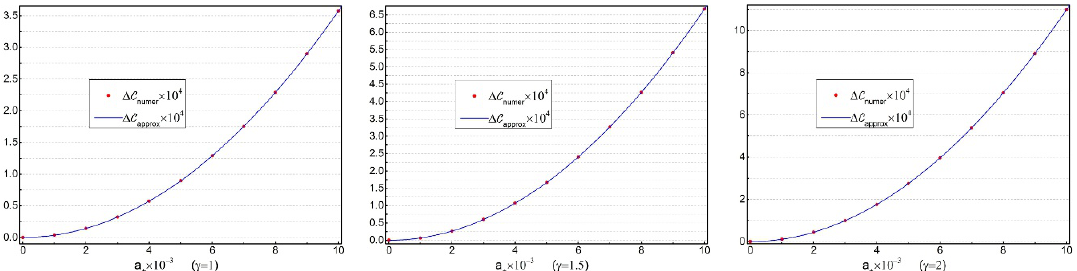
Figure 6 . Comparison between the quadratic approximation for small excitations, i.e., the second line of eq. (2.60), and the complexity found numerically for various target states. In the (cid:12)gures, we choose w + = 1 : 221 and w (cid:0) = 9 : 025 and a (cid:0) = (cid:13)a + . We let a + range from 0 to 0 : 01 and then compare the two results with (cid:13) = 1, 1.5 and 2. The three (cid:12)gures show excellent agreement between the quadratic approximation and the true complexity for a (cid:6) (cid:28)